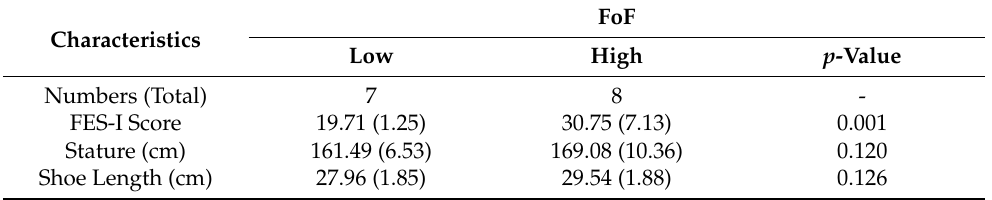
Table 1. Summary of fifteen participants’ characteristics—mean (SD) or N (%) within the FoF group. Characteristics